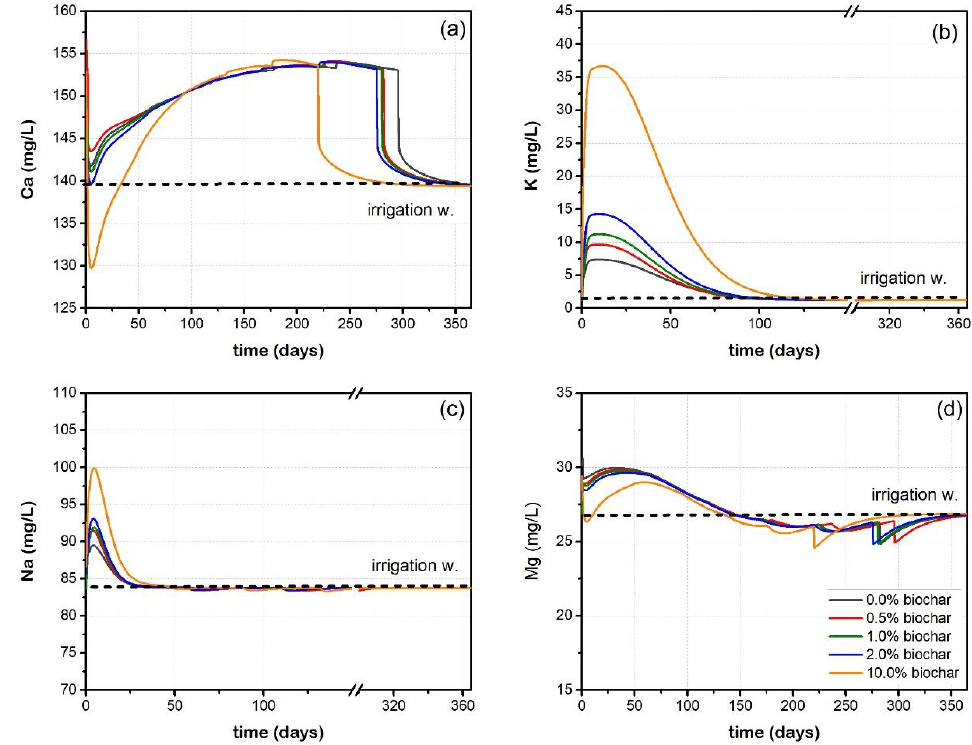
Figure 3. Elution curves of ( a ) Ca, ( b ) K, ( c ) Na and ( d ) Mg versus time as obtained from K.E. Model